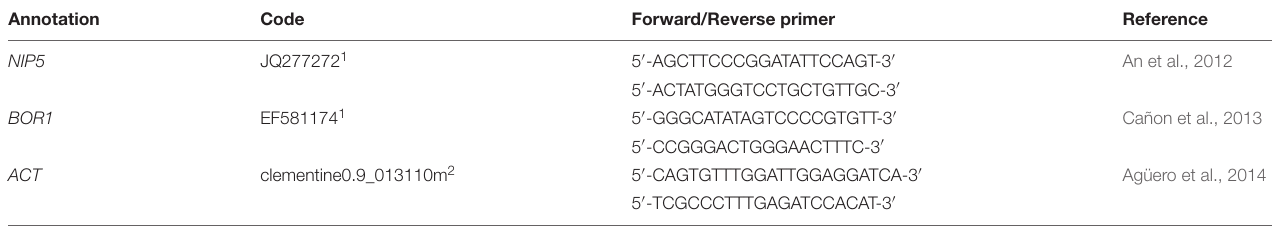
TABLE 1 | List of the primers used for quantitative reverse transcription